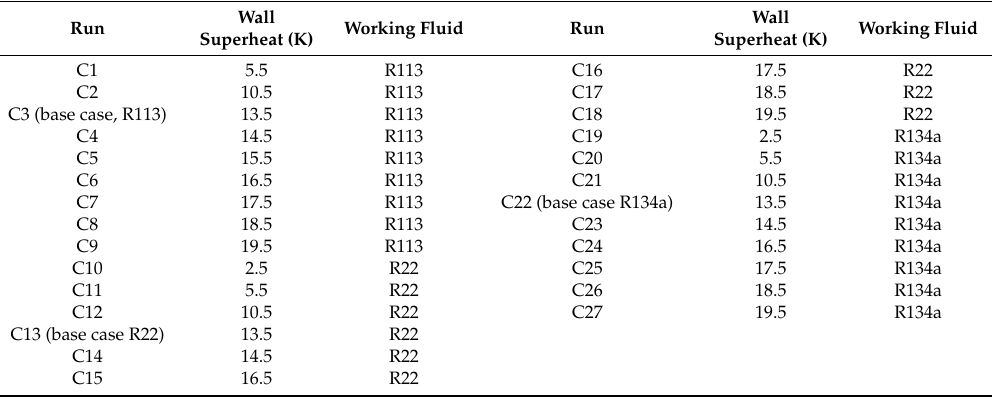
Table 6. Varied parameters in Series C of parametric numerical